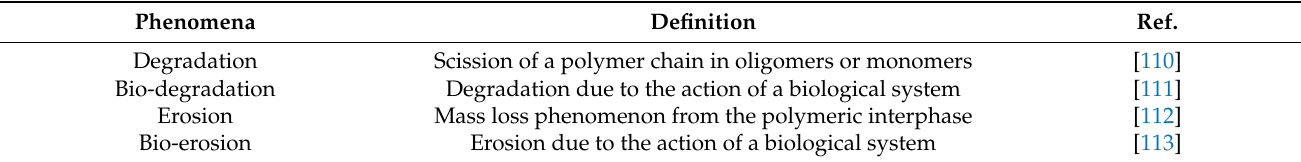
Table 2. Definition of general disrupting phenomena occurring in drug